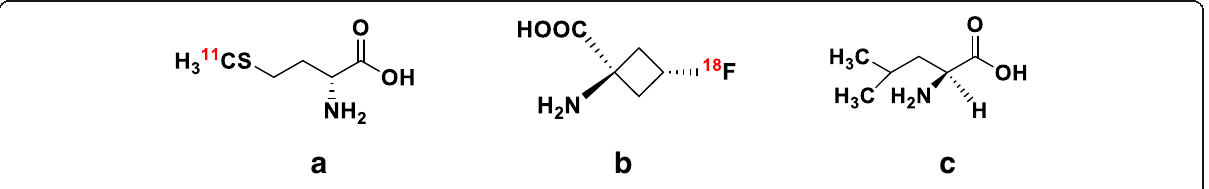
Fig. 1 Structures of amino acids. From left, a L -[ S - 11 C]methionine, b [ 18 F]FACBC, and c L